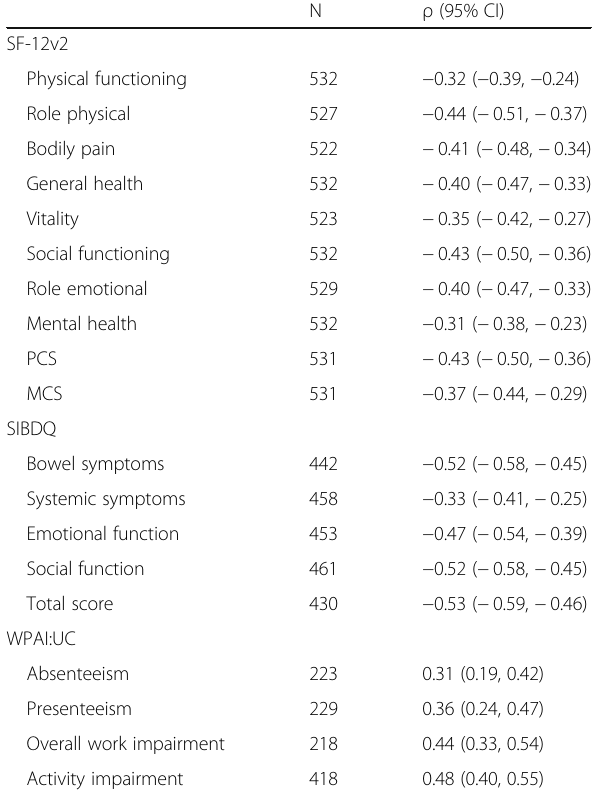
Table 7 Spearman correlation coefficients between changes in PRO scores and in UC-DAI total scores from baseline to Week 8 in the acute